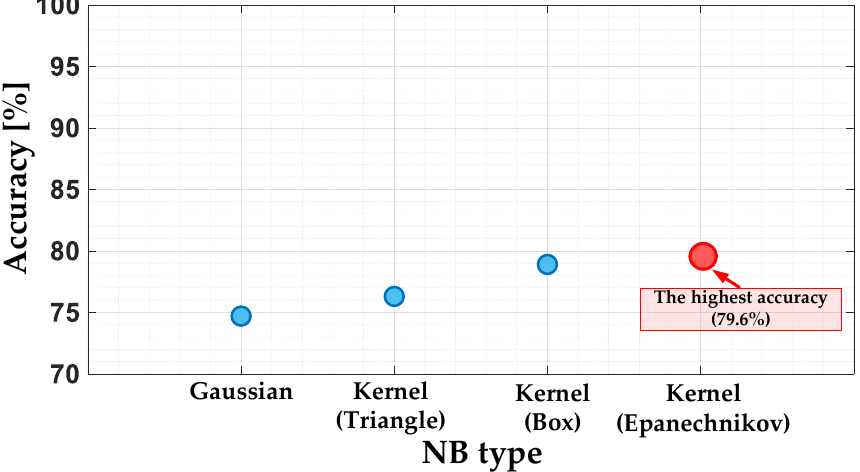
Figure 18. The impact of the NB type on the NB classifier accuracy.